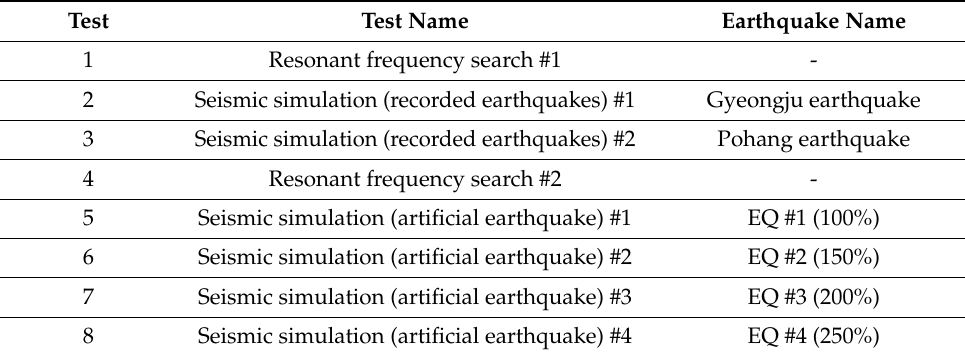
Table 6. Test procedure of the shaking